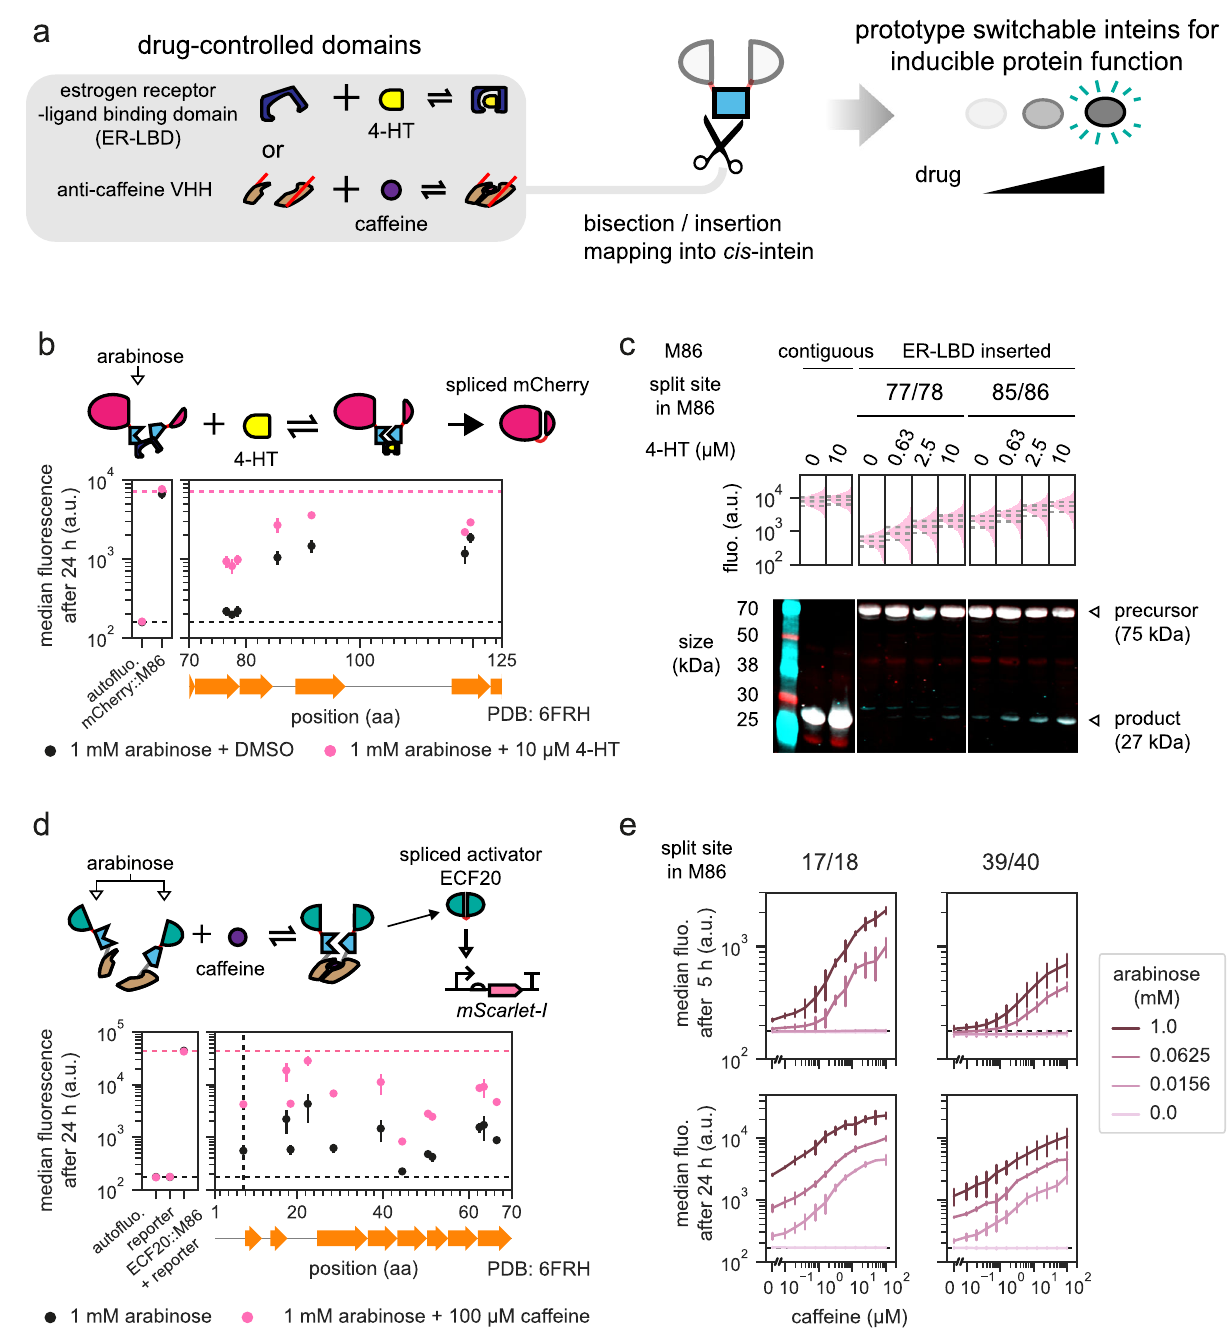
Fig. 4 Transposon as a tool to engineer inducibility into an intein for protein function control. a The M86 intein in its cis -form can be inserted in an identi fi ed split site within the protein of interest, and then bisected or inserted with drug-controlled domains, which leads to inducible splicing and inducible function of the host protein. b Seven insertion sites identi fi ed via domain-insertion mapping of the estrogen receptor-ligand binding domain into the M86 intein within mCherry interrupted at 192/193, where the addition of 4-hydroxytamoxifen (4-HT) led to increased fl uorescence. c Selected clones from b showed gradual increase in fl uorescence and spliced product formation as the concentrations of 4-HT increased, despite the fact that most precursors were unspliced. Single-cell fl uorescence values were obtained from one biological sample. Interquartile ranges are denoted by horizontal dashed lines. mCherry N-lobes were labeled in red and C-lobes were labeled in turquoise, and their superpositions give a white color. The result is representative of two independent experiments with similar results. d Eleven split sites for anti-caffeine VHH identi fi ed on the M86 intein that interrupted the activator ECF20 at 101/102. In those clones, the addition of caffeine led to increased activation activities. e Selected clones from d had increased activation activities as caffeine concentration increased, and leakiness due to spontaneous assembly could be mitigated by lowering the total split protein concentrations. y locations and error bars are mean and SD of median fl uorescence of three biological replicates each assayed on a different day ( n = 3). b , d Each vertical group of spots represents an identi fi ed insertion/split site, aligned to the M86 intein secondary structure. See Supplementary Figs. 19, and 22 for site distributions and activities at 5 h. y locations and error bars are mean and SD of median fl uorescence from experiments performed on 3 different days ( n ≥ 3, see Supplementary Data 2, sheet “ sample_sizes ” for exact values of n ). DMSO dimethyl sulfoxide. b , d , e Horizontal dashed lines bound the maximum ( b and d only) and minimum fl uorescence that could be achieved by the split or inserted